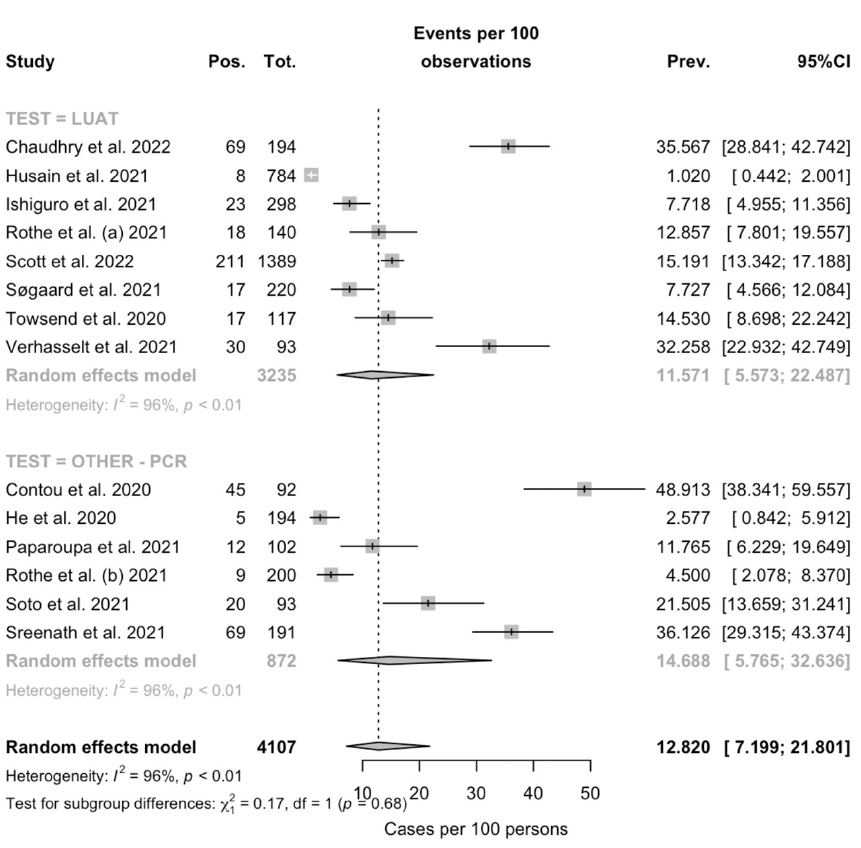
Figure A1. Forest plot representing the estimated case fatality ratio (CFR) among individuals affected by SARS-CoV-2 in the retrieved studies. Pooled CFR was estimated in 12.820% (95% Confidence Interval (95% CI) 7.199–21.801), with estimates that were considerably greater in PCR-based studies (14.688%, 95% CI 5.765–32.636) compared to those based on LUAT (11.571%, 95% CI 5.573–22.487)